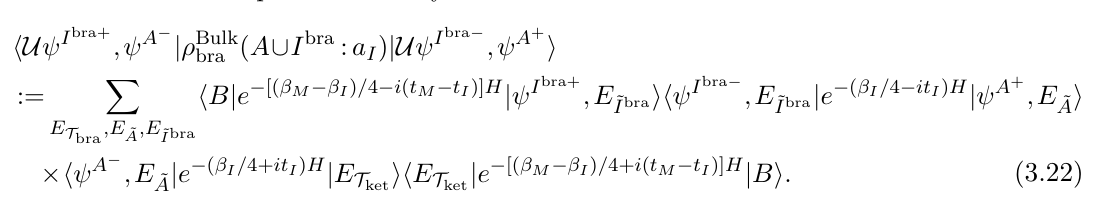
Figure 10 . Decomposition of the matrix element hU ψ I ket + , ψ A − | ρ Bulk in terms of basis E T , E ˜ , E ˜ of CFT subregions. Note that the time orderings of A ∓ and I ± . A I ket bra The initial boundary state now acts as a final state after CPT conjugation. Such CPT conjugation allows us to introduce the thermofield double state, and regard the initial state as a final state